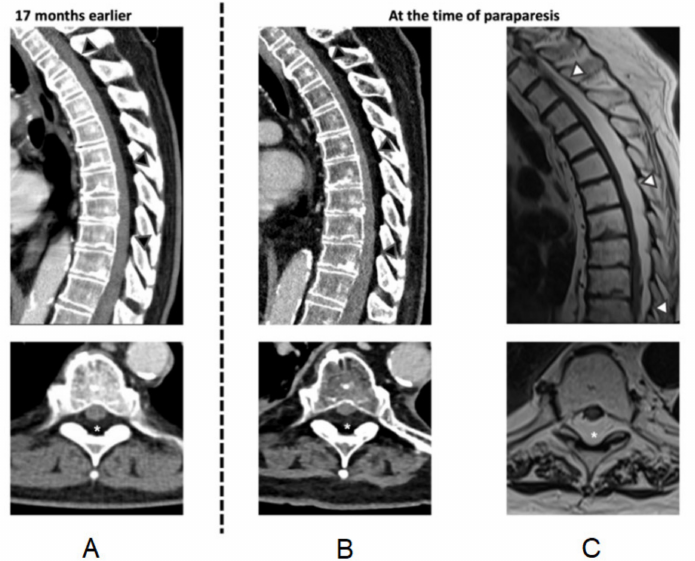
Figure 3. Preoperative imaging. ( A ) Retrospectively, SEL was already present in the CT performed during the diagnosis of lung cancer, 17 months earlier (sagittal and axial plane—at the level of T6). ( B ) Between the diagnosis of lung cancer and the paraparesis, the volume of the SEL increased signifi- cantly (preoperative CT in a sagittal and axial plane—at the level of T6) (see Figure 2). ( C ) Emergent MRI confirmed a fatty epidural tumor compressing the spinal cord (sagittal T1 TSE and axial T2 TSE at the level of T6), causing myelopathy at the level of T7–9 as shown by a low, patchy T2-hyperintense signal of the myelon at these levels. In addition, a general, atypical fat deposition pattern with an increase of epidural, mediastinal, and subcutaneous fat as well as fatty muscle atrophy was observed ( A vs. B , C ). The extent of SEL is highlighted in the sagittal planes by arrowheads and in the axial planes by asterisks. The mass severely compressed the spinal cord, which was ventrally